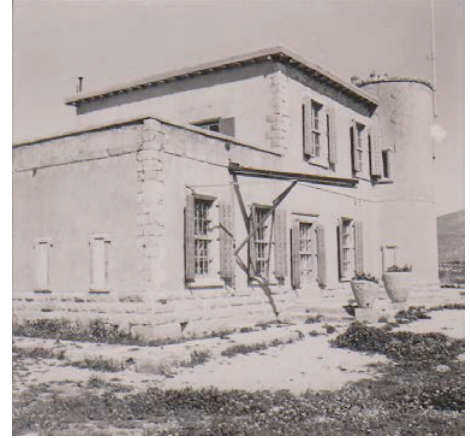
Fig. 5: A view of the front of ‘Antiquity House’. (Copyright UCL Institute of